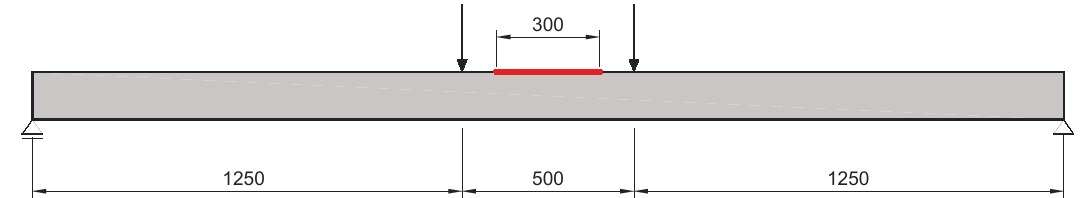
Fig. 5. Diagram of support and load of the 180  140 guide